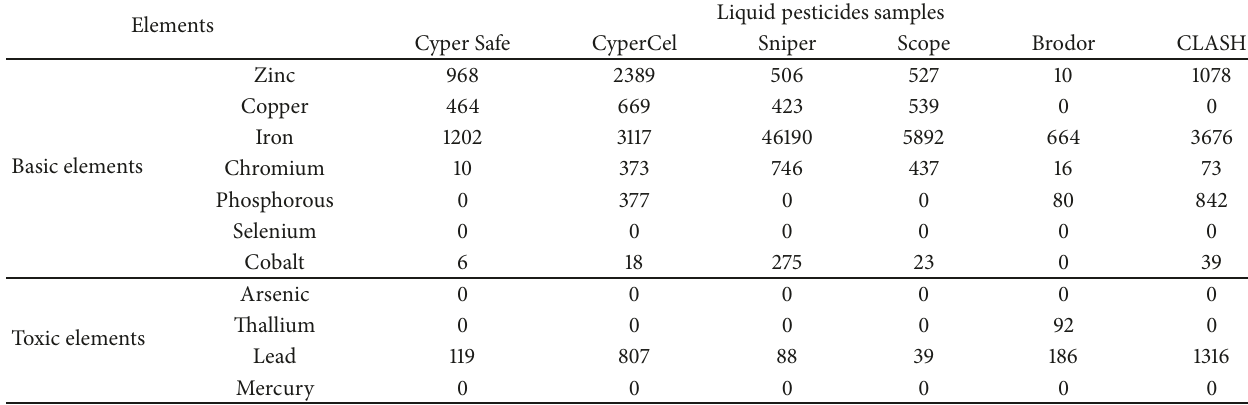
Liquid pesticides samples